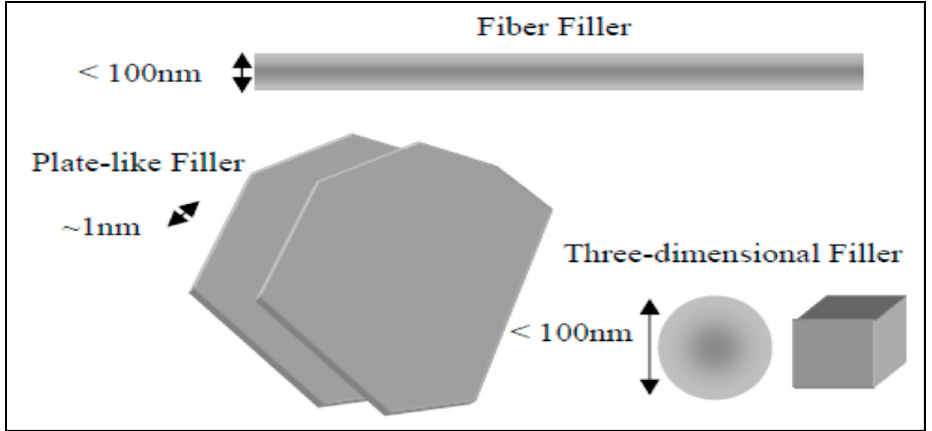
Figure 1. Schematic illustration of nanoscale